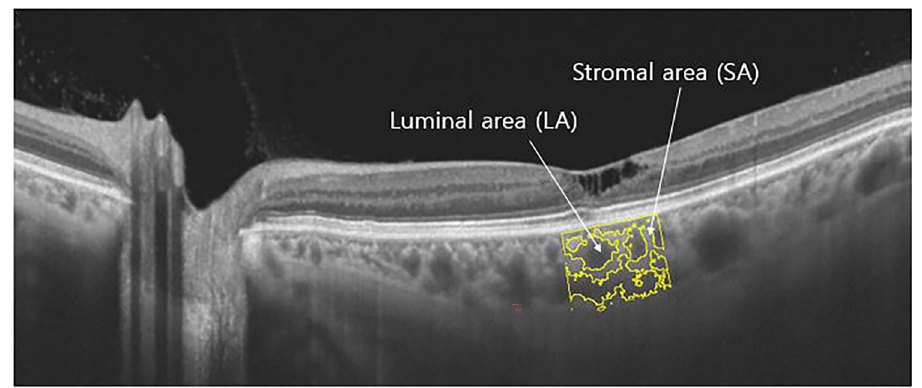
Fig 1. Representative swept source OCT image of Mactel type 2 eye to measure the CVI. The subfoveal region of 1,500 μ m was separated to the luminal area (LA) and the stromal area (SA).